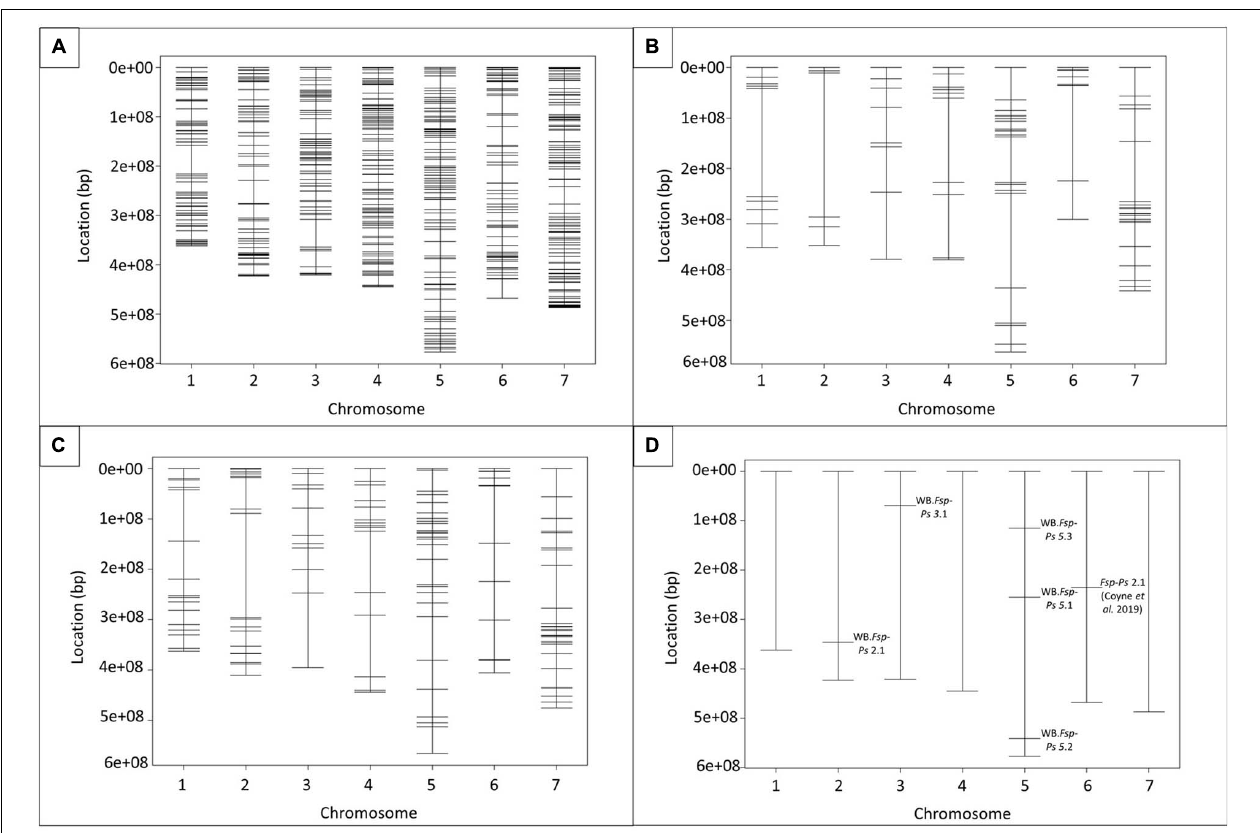
FIGURE 2 | Physical maps of SNPs and QTLs identified in the seven Pisum sativum chromosomes. Location of 769 SNPs, mined from Fsp -responsive differentially expressed genes (DEGs), in pea genome (A) . Total of 100 and 154 SNPs with validated polymorphisms for population I (“Aragorn” × 00-5001) (B) and population II (“Banner” × 00-5007) (C) , respectively. Five QTLs were identified in association with disease resistance (D) . Major QTL Fsp-Ps 2.1 (Coyne et al., 2019) was added as a reference (D) . Physical distances, represented in base pairs (bp), are shown on the left side of the